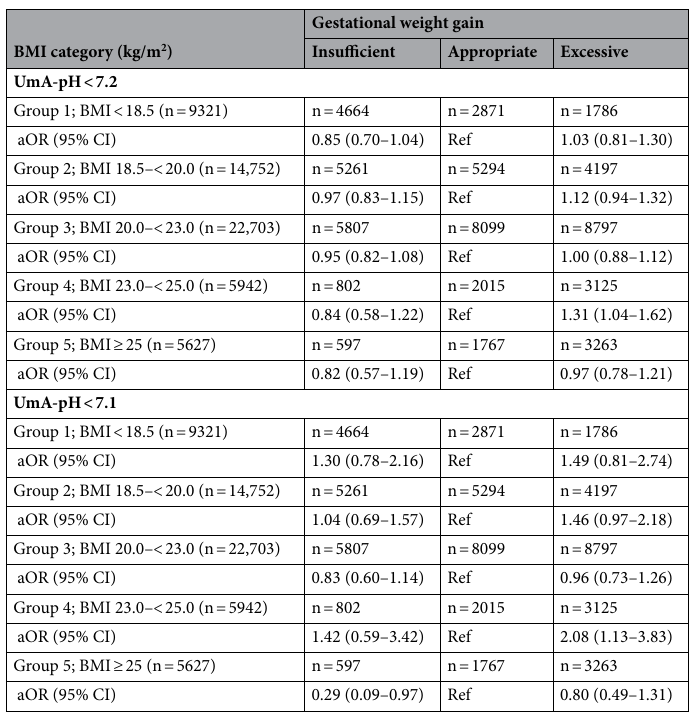
Table 4. Adjusted odds ratios a and 95% confidence intervals for foetal acidosis based on gestational weight gain with vaginal deliveries according to Japanese criteria 28 . Logistic regression models were used to calculate the adjusted odds ratios and 95% confidence intervals for UmA-pH < 7.20 and for UmA-pH < 7.10, with women with appropriate gestational weight gain as the reference. BMI body mass index, UmA-pH umbilical artery pH. a Adjusted for maternal age, maternal education, annual household income, maternal smoking during pregnancy, parity, preterm birth and small-for-gestational age